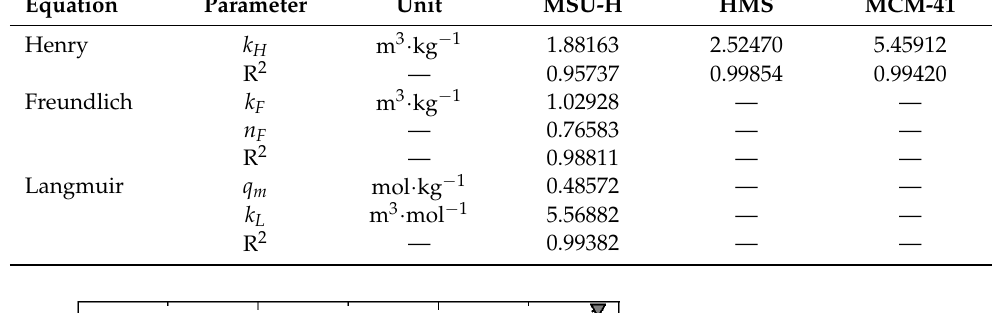
Figure A12. Uptake of Rh(acac) 3 at 15 MPa and 353 K on different substrates; experimental data taken from [62]. Table A12. Adsorption isotherm parameters for Rh(acac) 3 from scCO 2 solution at 15 MPa and 353 K on different substrates [62].